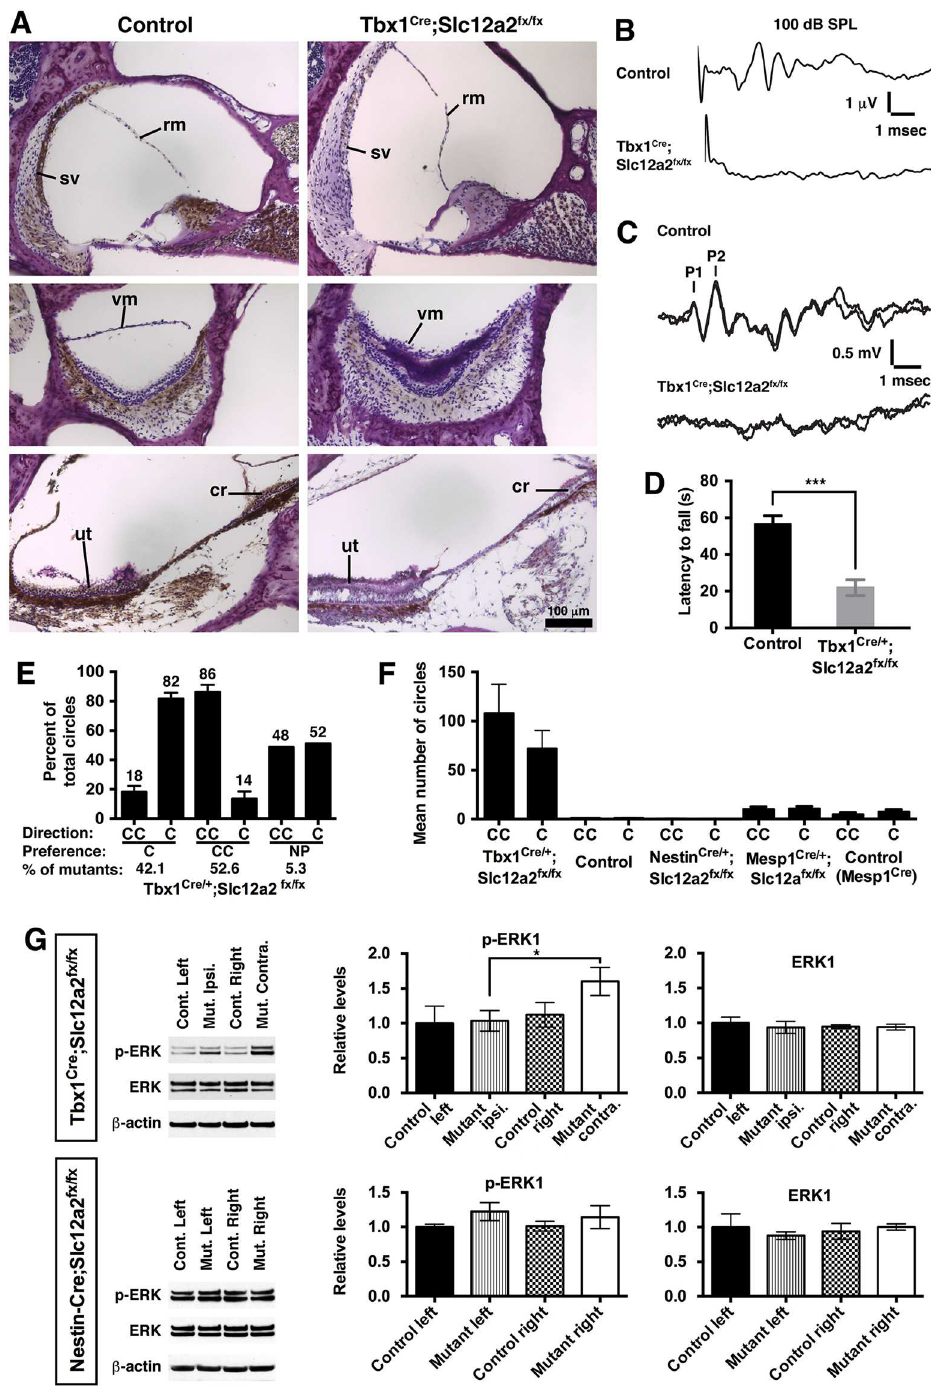
Fig 6. Atypical asymmetries in brain function and behavior are caused by inner ear dysfunction. (A) Immunohistochemical staining of inner ear sections showed reduced SLC12A2 expression (brown) in Tbx1 Cre/+ ; Slc12a2 fx/fx mutants (Nissl counterstain, purple) and defects of the cochlea (top panel) and vestibular structures: saccular vestibular membrane collapse (middle) and ut and cr degeneration (bottom). (B) ABR testing revealed no waveforms at 100 decibels, sound pressure level, in 6-week-old mutants, indicative of deafness. (C) VsEP (P1, first peak; P2, second peak) were absent in mutants, indicative of vestibular impairment. (D) Mutants performed poorly on the rotarod test ( p < 0.0001), consistent with impaired balance. Mean ± SEM, n = 8 mice/genotype, two-tailed t test. See also S1 Data. (E) Open field recordings of Tbx1 Cre/+ ; Slc12a2 fx/fx mutants showed a turning bias in either the